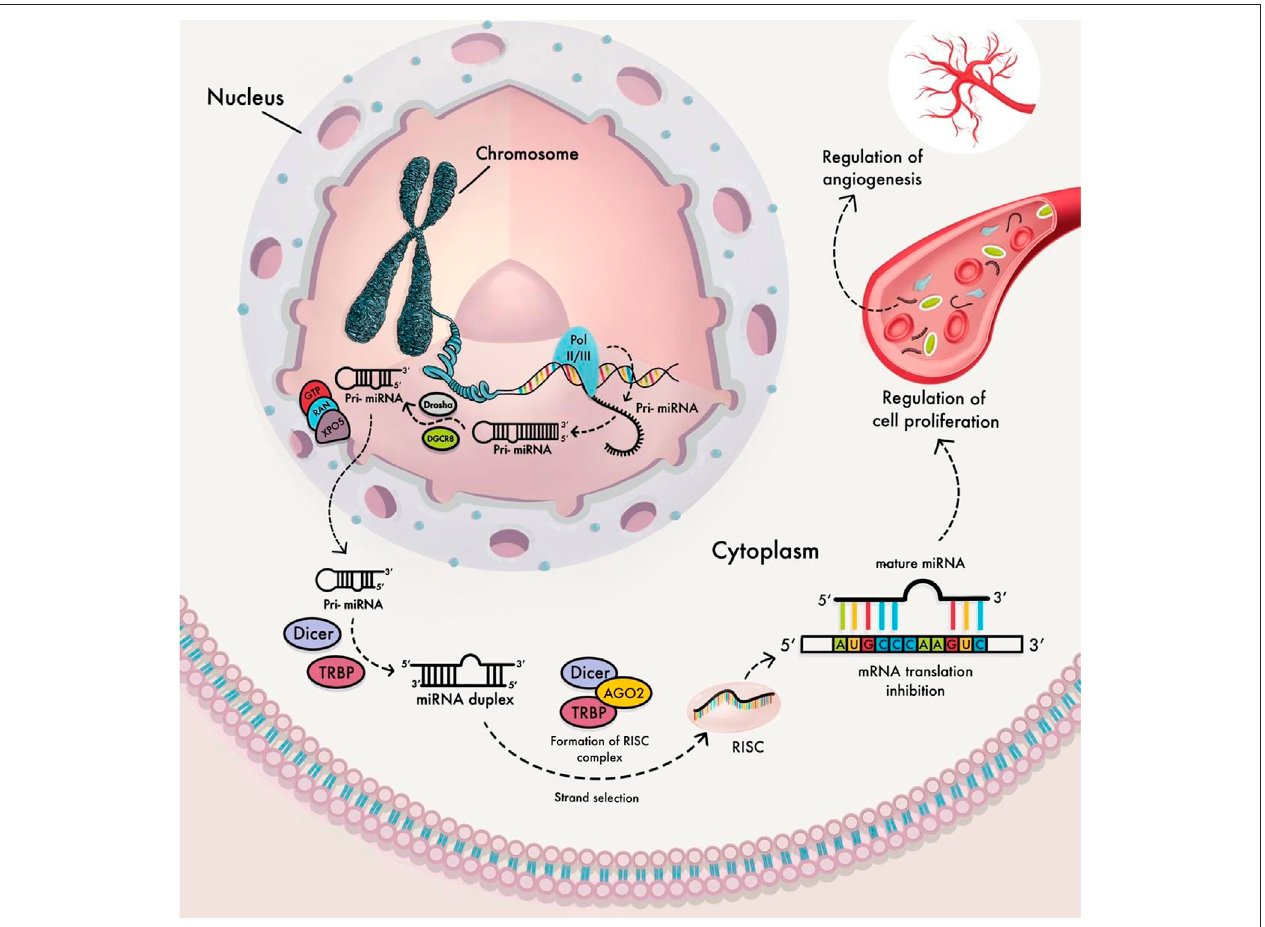
FIGURE3| miRNAbiogenesispathway.Inthenucleus,RNApolymeraseIItranscriptsmiRNAgenestoproduceprimarymiRNAtranscript(pri-miRNA),thenbythe microprocessor complex Drosha-DGCR8 cleaved into precursor miRNA (pre-miRNA). After that, Exportin-5 transports the pre-miRNA into the cytoplasm, where it is processedintoamiRNAduplexbyDiceranditsinteractionprotein,TRBP.OncethemiRNAduplexhasbeenunwinding,itisdividedintotwosingle-strandedmiRNAsfor further processing. Mature miRNA is attached to the RNA-induced silencing complex (RISC) and mediates mRNA degradation or repression of protein translation within the cytoplasm. Mature active miRNAs inter to cell proliferation regulation by controlling the angiogenesis process in the tumor